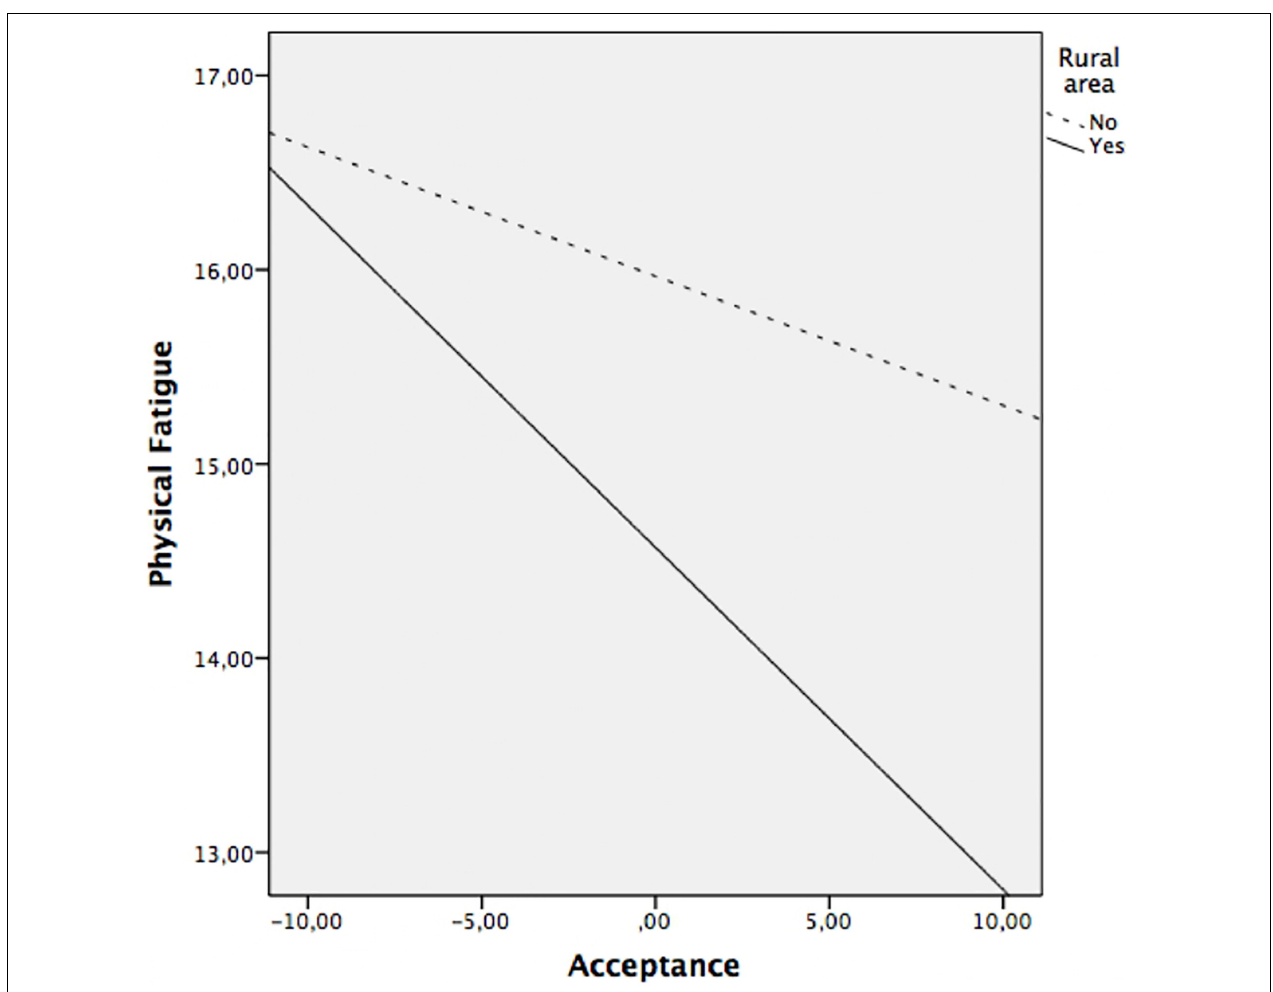
FIGURE 3 | Relationship between acceptance and physical fatigue at rural area